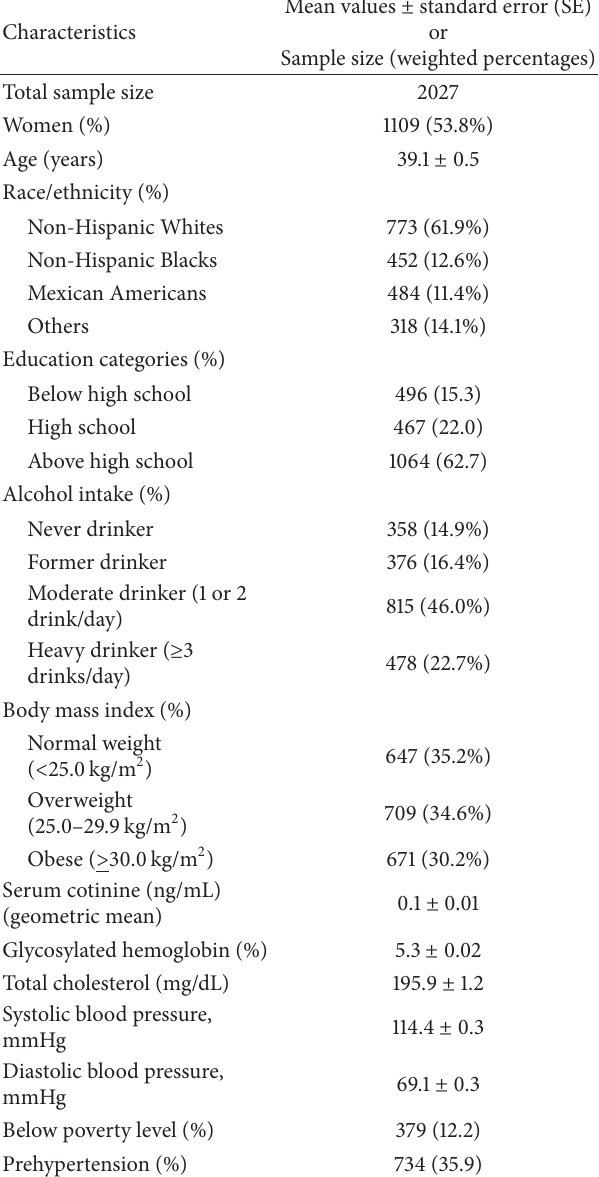
Table 1: Baseline characteristics of the study